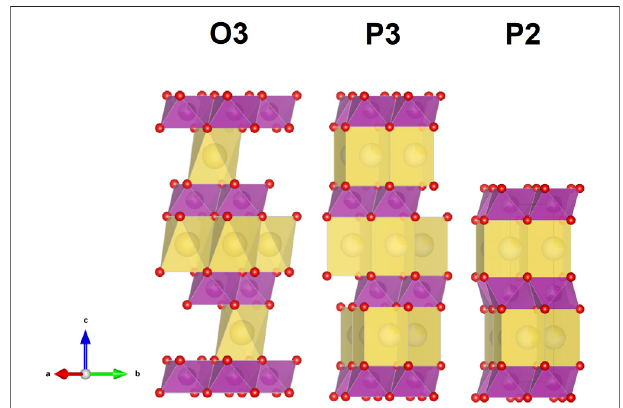
FIGURE 1 | Crystal structures obtained during synthesis of sodium layered transition metal oxides and their description in Delmas notation (O3, P3 and